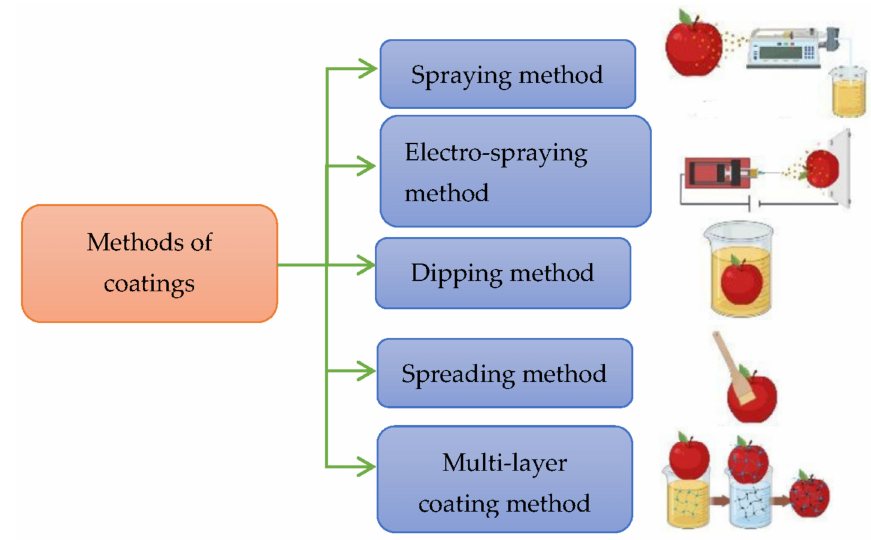
Figure 9. Methods used for coating fruits and vegetables [22].